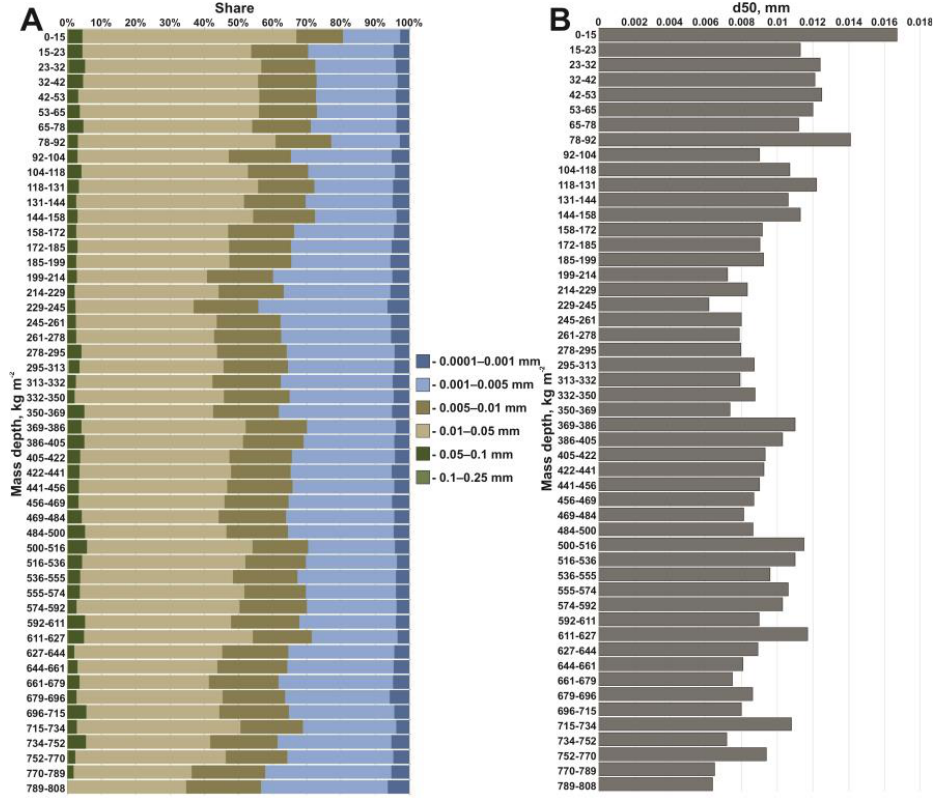
Figure 11. Grain-size composition of bottom sediments accumulated after 1986: ( A ) proportion of particles of different sizes; ( B ) median particle sizes (d50) (according to data from Core 6).